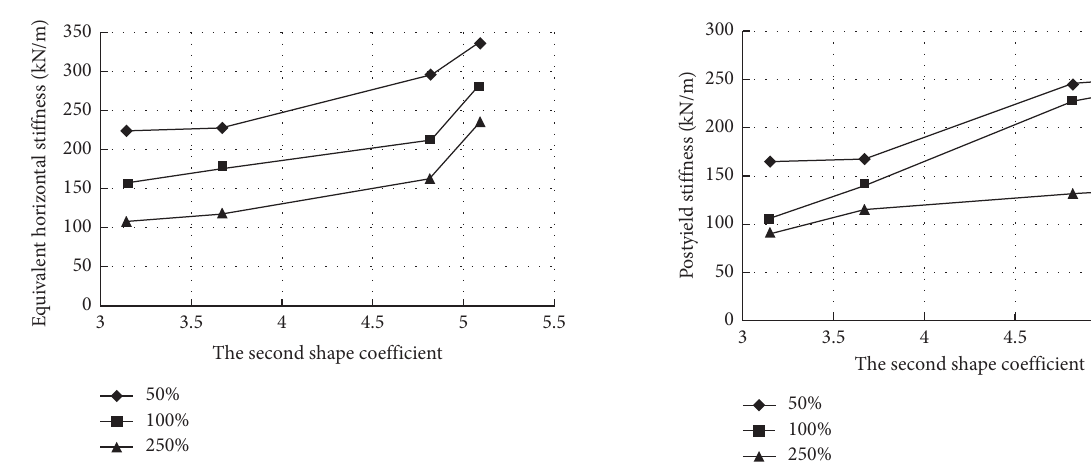
Figure 18: Postyield stiffness related to the second shape